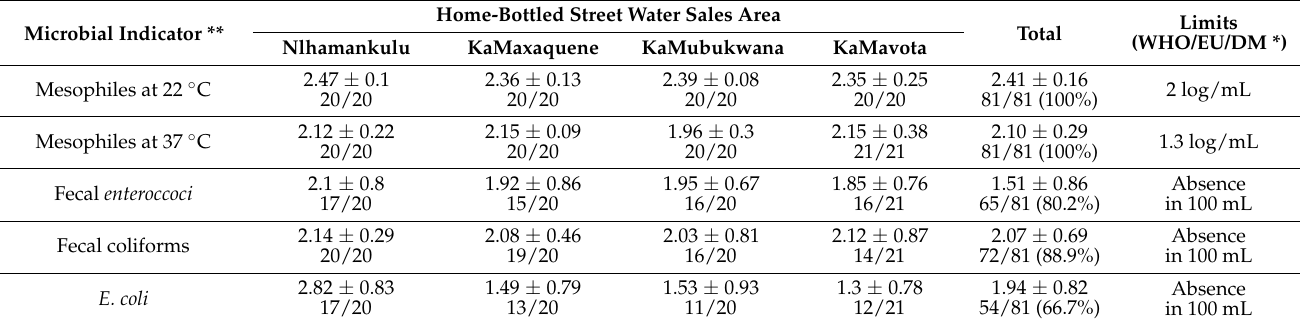
Table 5. Evaluation of home-bottled street water sold in four municipal districts of Maputo, according to each microbial indicator for drinking water. Number of samples with contamination higher than the limits and total percentage (%) are